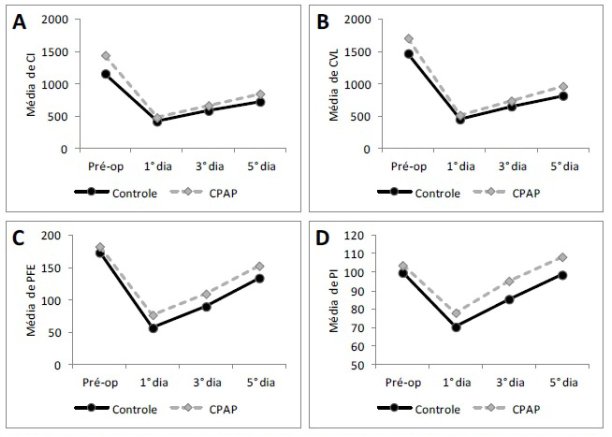
Monitoring of inspiratory capacity (IC), slow vital capacity (SVC), peak expiratory flow (PEF), and maximal inspiratory pressure (MIP) over time in the control and CPAP groups. (A) Distribution of the changes in IC preoperatively (pre-op) and on the 1st, 3rd, and 5th postoperative days (PODs) (p<0.05 intragroup; p<0.05 between groups, except for pre-op: p = 0.03); (B) Distribution of the changes in SVC pre-op and on the 1st, 3rd, and 5th PODs (p <0.05 intragroup; p<0.05 between groups); (C) Distribution of the changes in PEF pre-op and on the 1st, 3rd, and 5th PODs (p <0.05 intragroup,; p<0.05 between groups, except on 1st POD: p=0.042); (D) Distribution of the changes in MIP pre-op and on the 1st, 3rd, and 5th PODs (p<0.05 intragroup except the 5th POD: p>0.05; p <0.05 between groups).